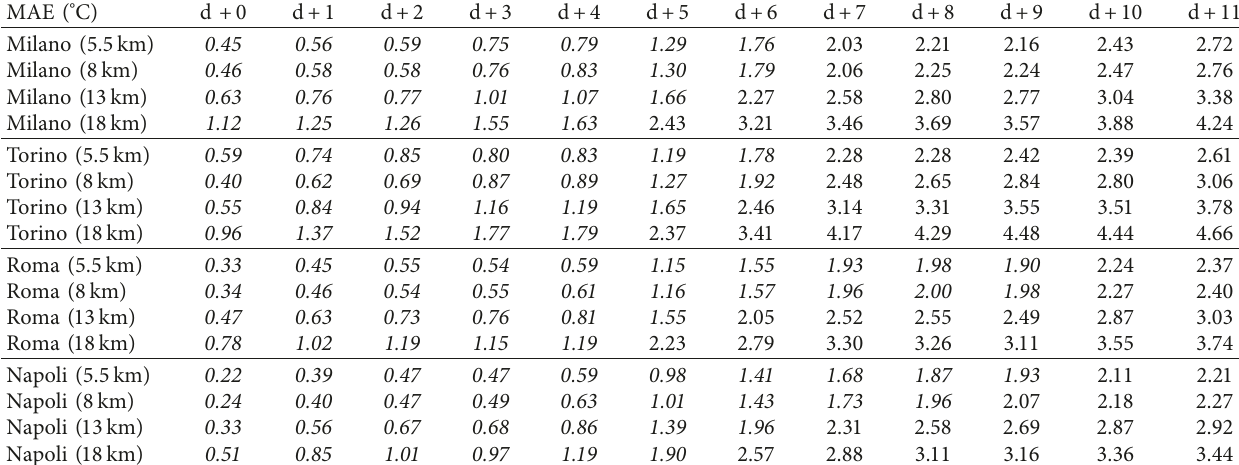
Table 1: MAE of the e-kmf ™ temperature forecasts at different spatial resolutions and lead times over the Italian cities; values in italics depict a forecast below the 2 ° C error threshold.